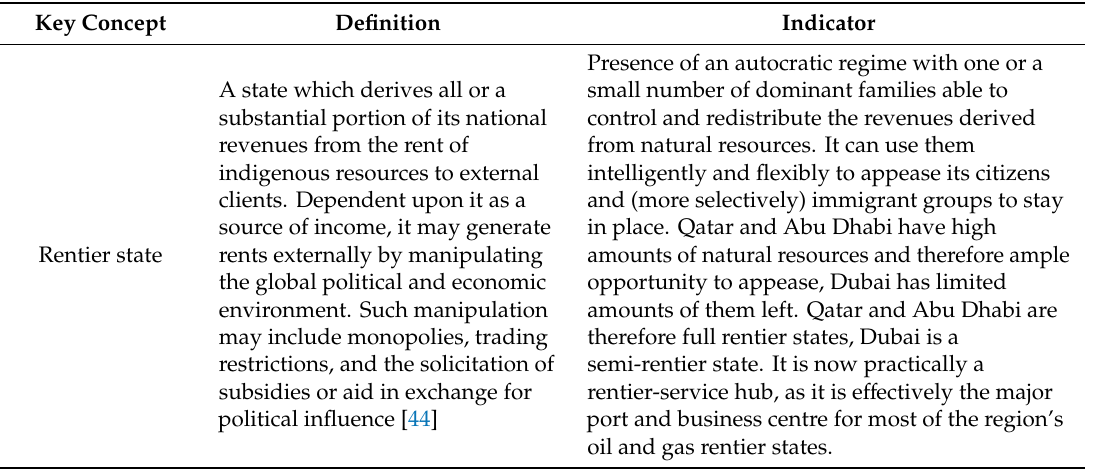
Table 1. Definition and measurement of key concepts in the present